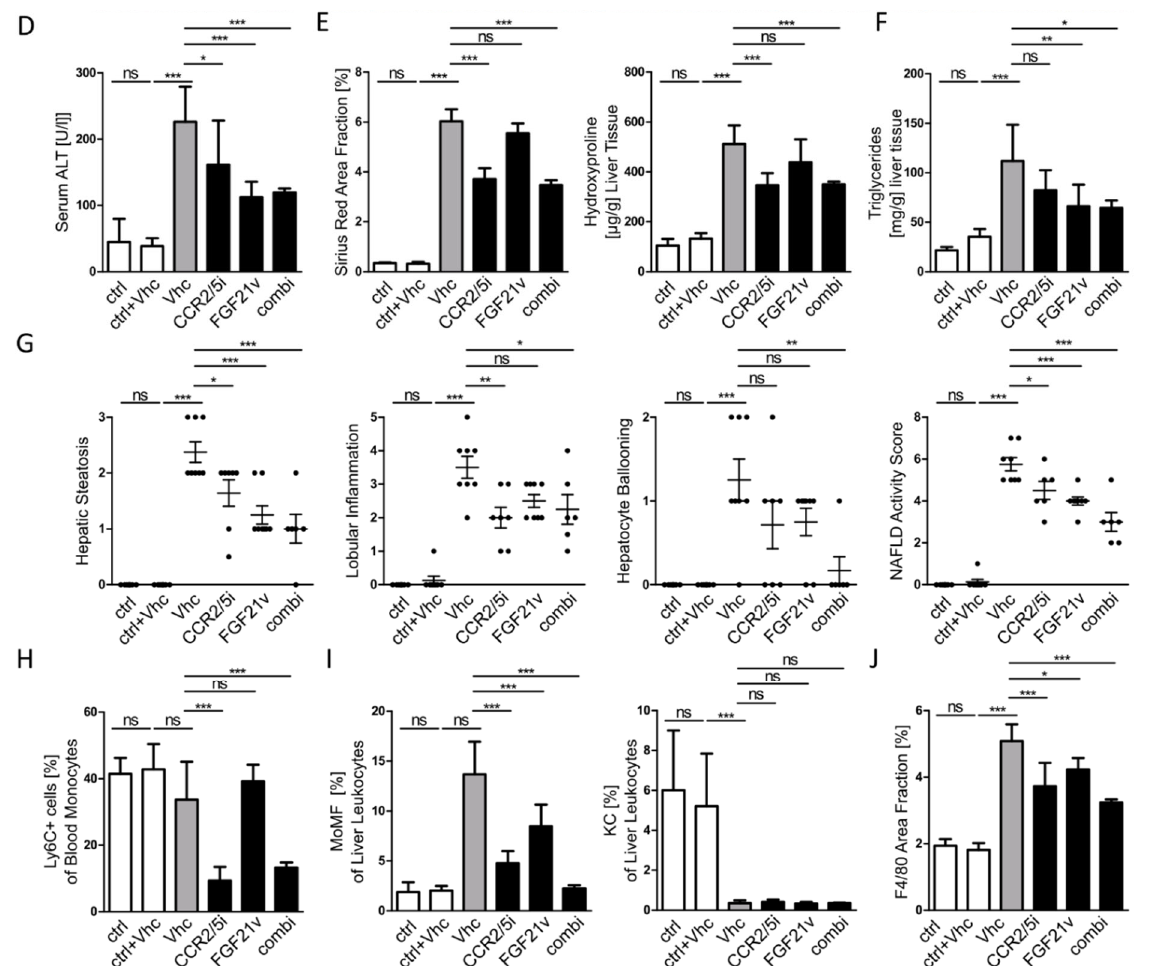
Figure 2. Combination therapy by dual CCR2/CCR5 inhibition and FGF21 agonism ameliorates steatohepatitis and fibrosis more effectively than single drug treatment. ( A ) Pharmacologic treatment with CCR2/CCR5 inhibitor (CCR2/5i) and/or PEG-FGF21 variant (FGF21v) was conducted over the last 6 weeks of 12 weeks CDAHFD (choline-deficient, amino acid-defined high-fat diet) admin- istration to induce steatohepatitis and fibrosis. ( B ) Line graph of bodyweight development of all treatment groups (ctrl: control diet; Vhc: vehicle). ( C ) Representative H&E, Sirius Red and F4/80 immunohistochemistry staining ( × 10 magnification; scale bars = 100 µ m. ( D – F ) Assessment of liver injury by serum alanine transaminase levels (ALT), of liver fibrosis by quantification of Sirius Red area fraction and hydroxyproline content and of hepatic triglyceride content. ( G ) Single parameters of the histopathological NAFLD activity score (NAS). ( H – J ) Quantification of flow cytometry for Ly6C+ blood monocytes, hepatic monocyte-derived macrophages (MoMF) and Kupffer cells (KC) and quantification of F4/80 positive area fraction. All data are presented as mean SD ( n ≥ 6 per group), ns = non-significant, * p < 0.05, ** p < 0.01, *** p < 0.001 (one-way ANOVA with post-hoc